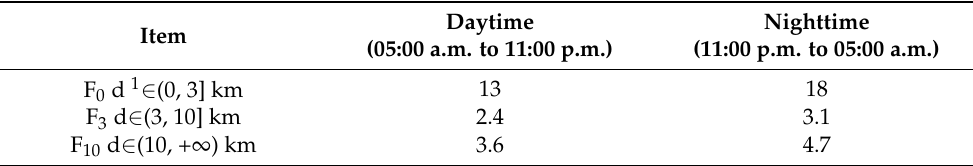
Table 3. The charging mode for Shanghai taxis in 2015 (CNY). Item